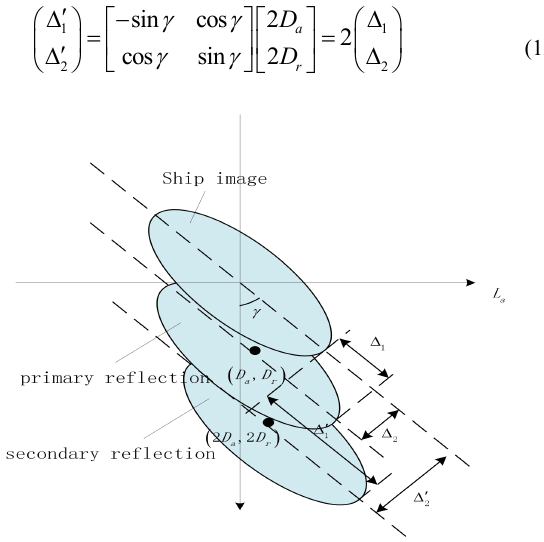
Figure 4.Simplified model of ship image and its secondary reflection